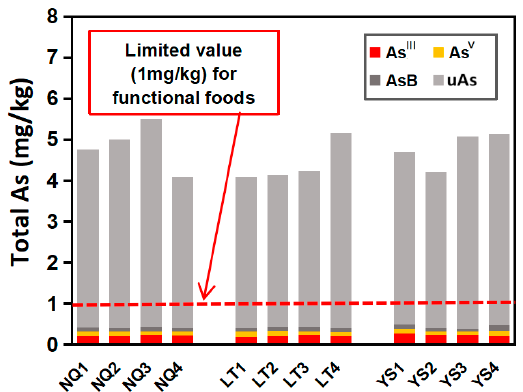
Figure 3. The concentration (mg/kg dry weight) of total As and As speciation detected in O. sinensis . Inorganic As ( As III and As V ) are shown in red and yellow sections, and organic As ( AsB and uAs) is shown in dark and light gray sections.